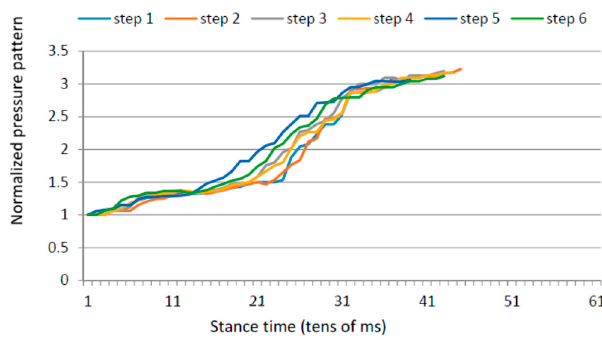
Figure 13. Lateral centre of pressure in the first six steps for a stroke survivor.